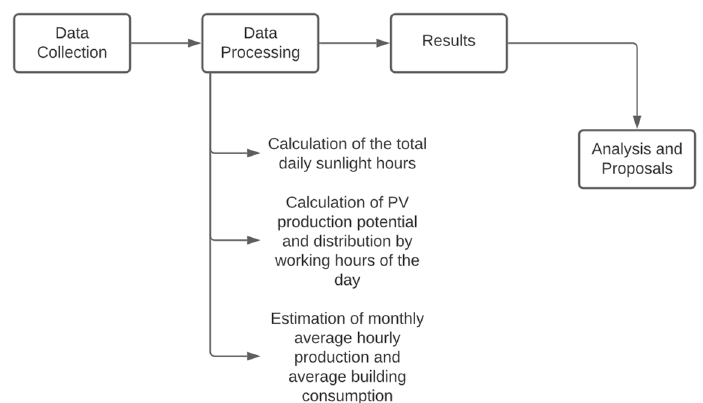
Figure 2. The methodological algorithm used in the study.